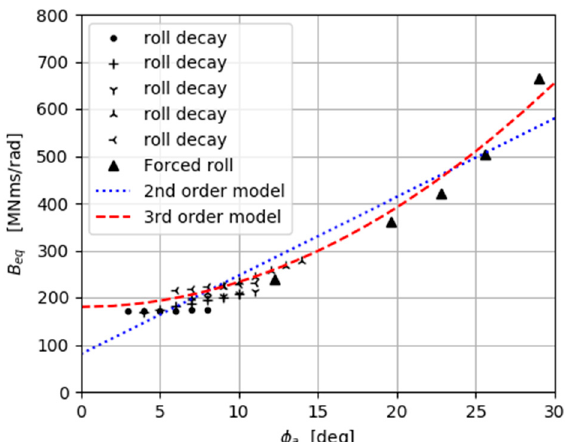
Figure 1. Roll damping for LC-1 at ω φ = 0.273 rad/s and Vs = 8 kn. Results of forced roll tests (full triangles) and of roll decay tests (other symbols). The best-fit quadratic model is displayed as a dotted blue line, a cubic model is displayed as a red dashed line.